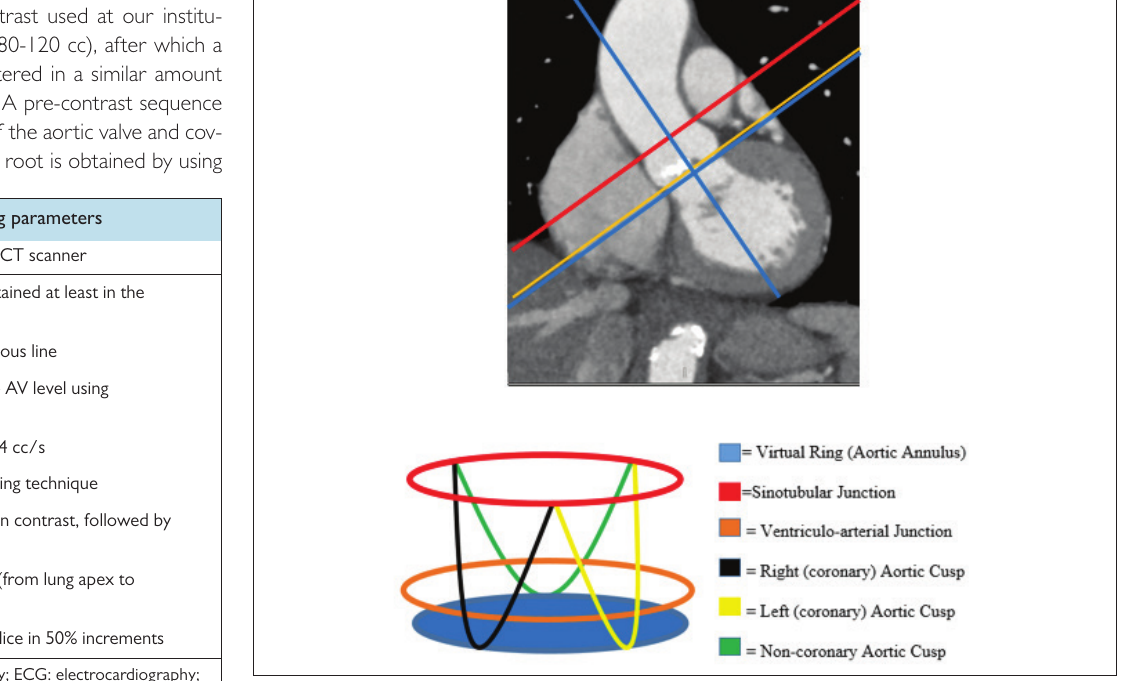
Figure 1. Aortic root